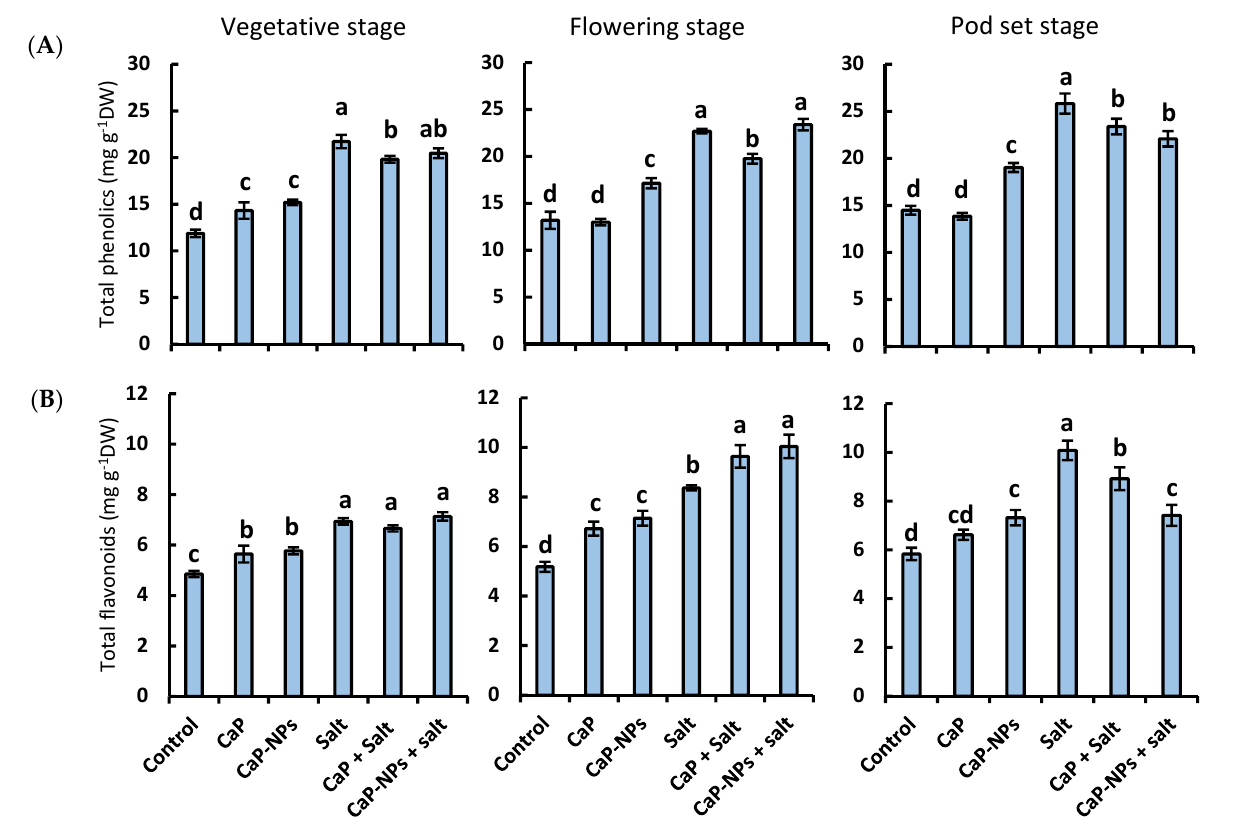
Figure 10. Effect of different treatments on ( A ) the total phenolics and ( B ) total flavonoid content of broad bean plants in 3 growth stages. The same letters indicate no significant difference ( p < 0.05) as analyzed by the Duncan test. Each value is the average of 3 replicates ± SE.